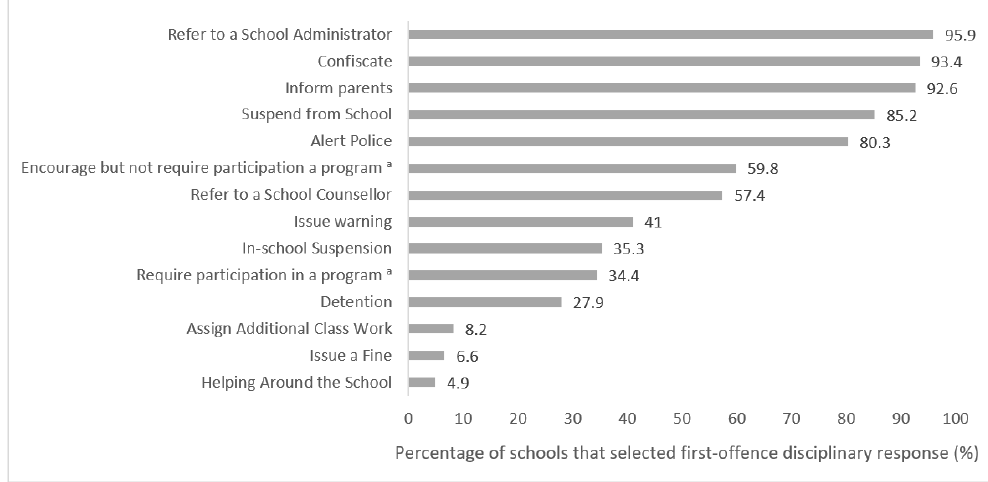
Figure 1. Frequency of various first-offence disciplinary approaches selected by schools ( n = 122) as being used in response to student violations of school cannabis policies in Year 6 (2017/2018) of the COMPASS study. a Assistance, education, or cessation program. Note: The question used a “check all that apply” design.